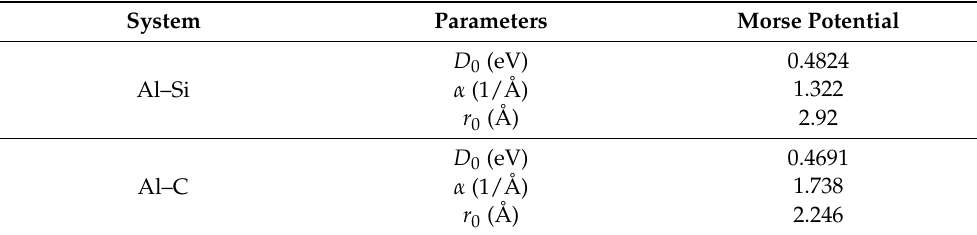
Table 5. The Morse potential parameters to model Al–Si and A–C interactions [41]. System Parameters Morse